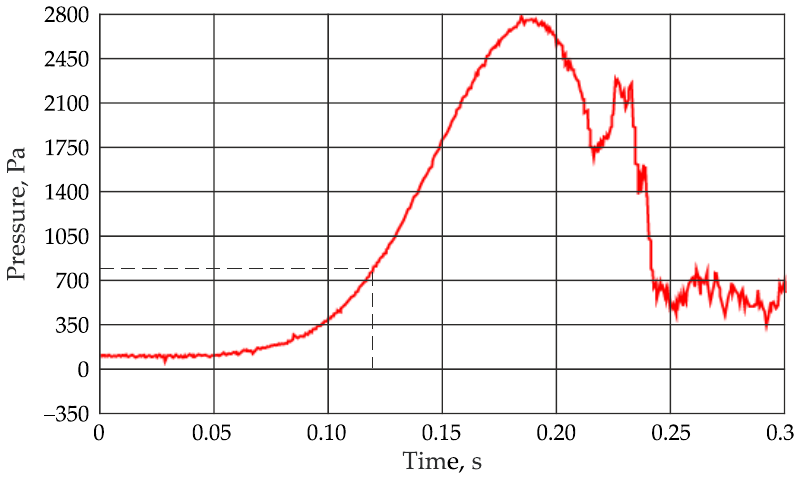
Figure 7. Experimental waveforms of excessive pressure when testing EVS #3 sample. Figure 8 provides instant photos of several moments of a deflagration explosion process inside the chamber involving shedding of an EVS installed in the relief opening.